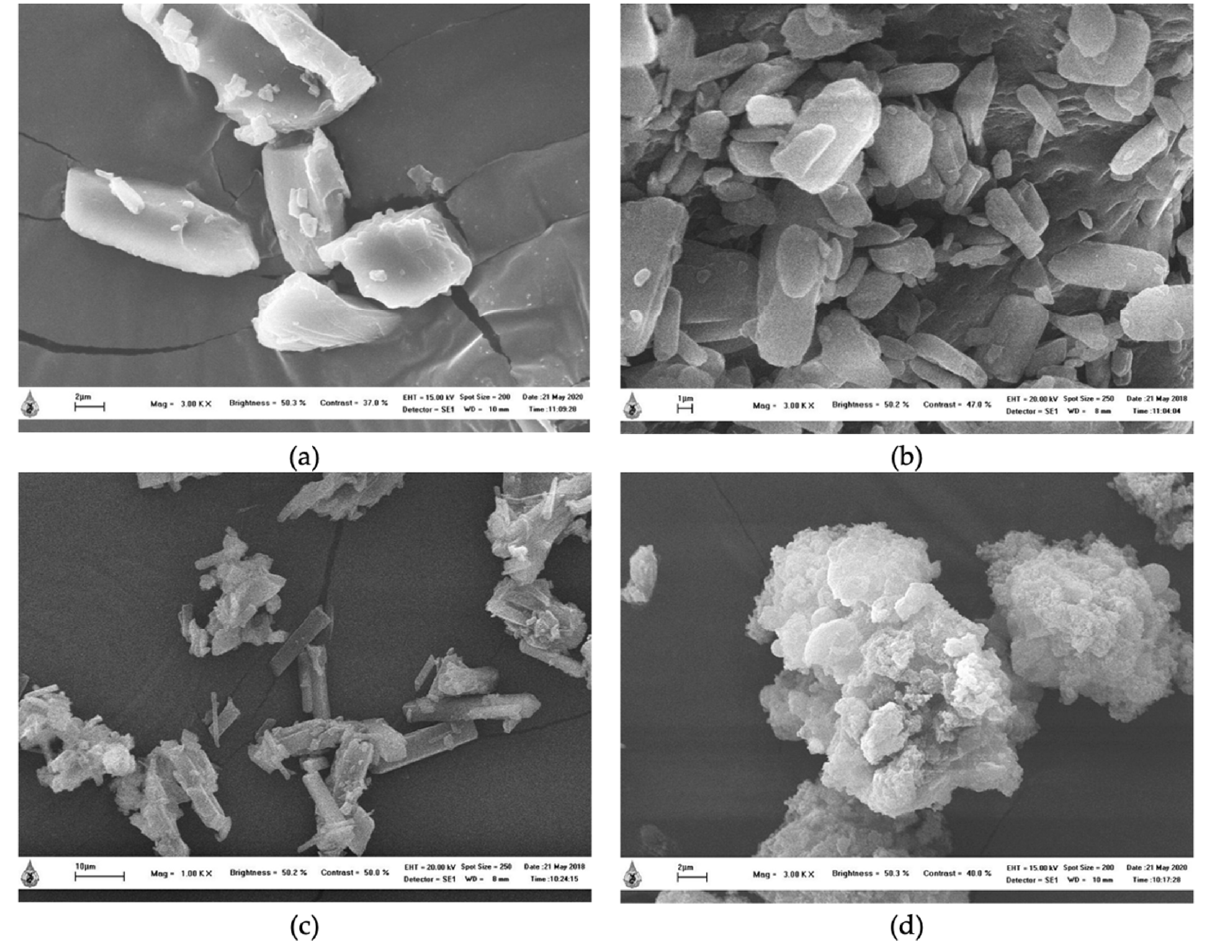
Figure 1. SEM images of PRS ( a ), FA ( b ), physical mixture, ( c ) and encapsulated FA ( d ).